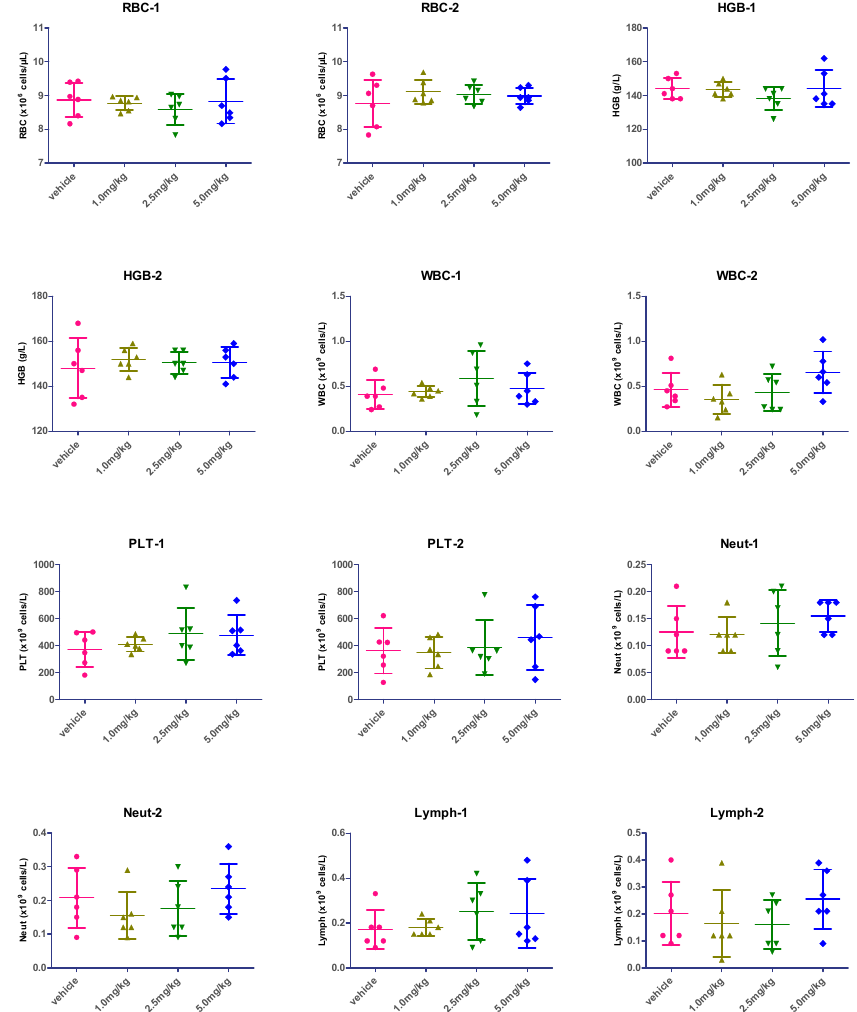
Figure 8. Hematological analysis of VA-based ADC (mil40- 12b ). Numbers “ 1 ” and “ 2 ” represent the first and second sampling on Days 28 and Days 58, respectively. Red blood cells (RBCs), hemoglobin (HGB), white blood cells (WBCs), platelets (PLTs), neutrophils (Neuts) and lymphocytes (Lymph) were analyzed. Results are shown as mean ± SD, n = 6/group. Table 2. The p value in the unpaired t -test between the vehicle and ADC treatment groups. Groups vehicle vs. 2.5 mpk